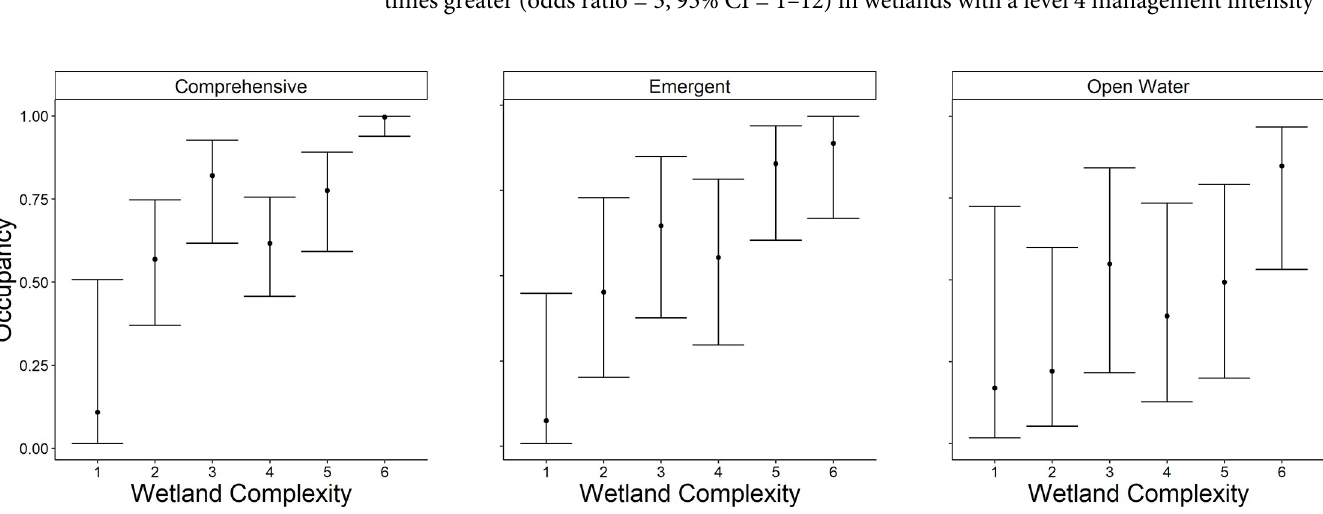
(odds ratio = 0.70; 95% CI = 0.02–0.77) between NWI wetlands and CTAP wetlands (Fig 5). Occupancy was greatest at intermediate levels of waterfowl management intensity. For instance, the probability of open water-associated marsh birds occupying a wetland was 3 times greater (odds ratio = 3, 95% CI = 1–12) in wetlands with a level 4 management intensity